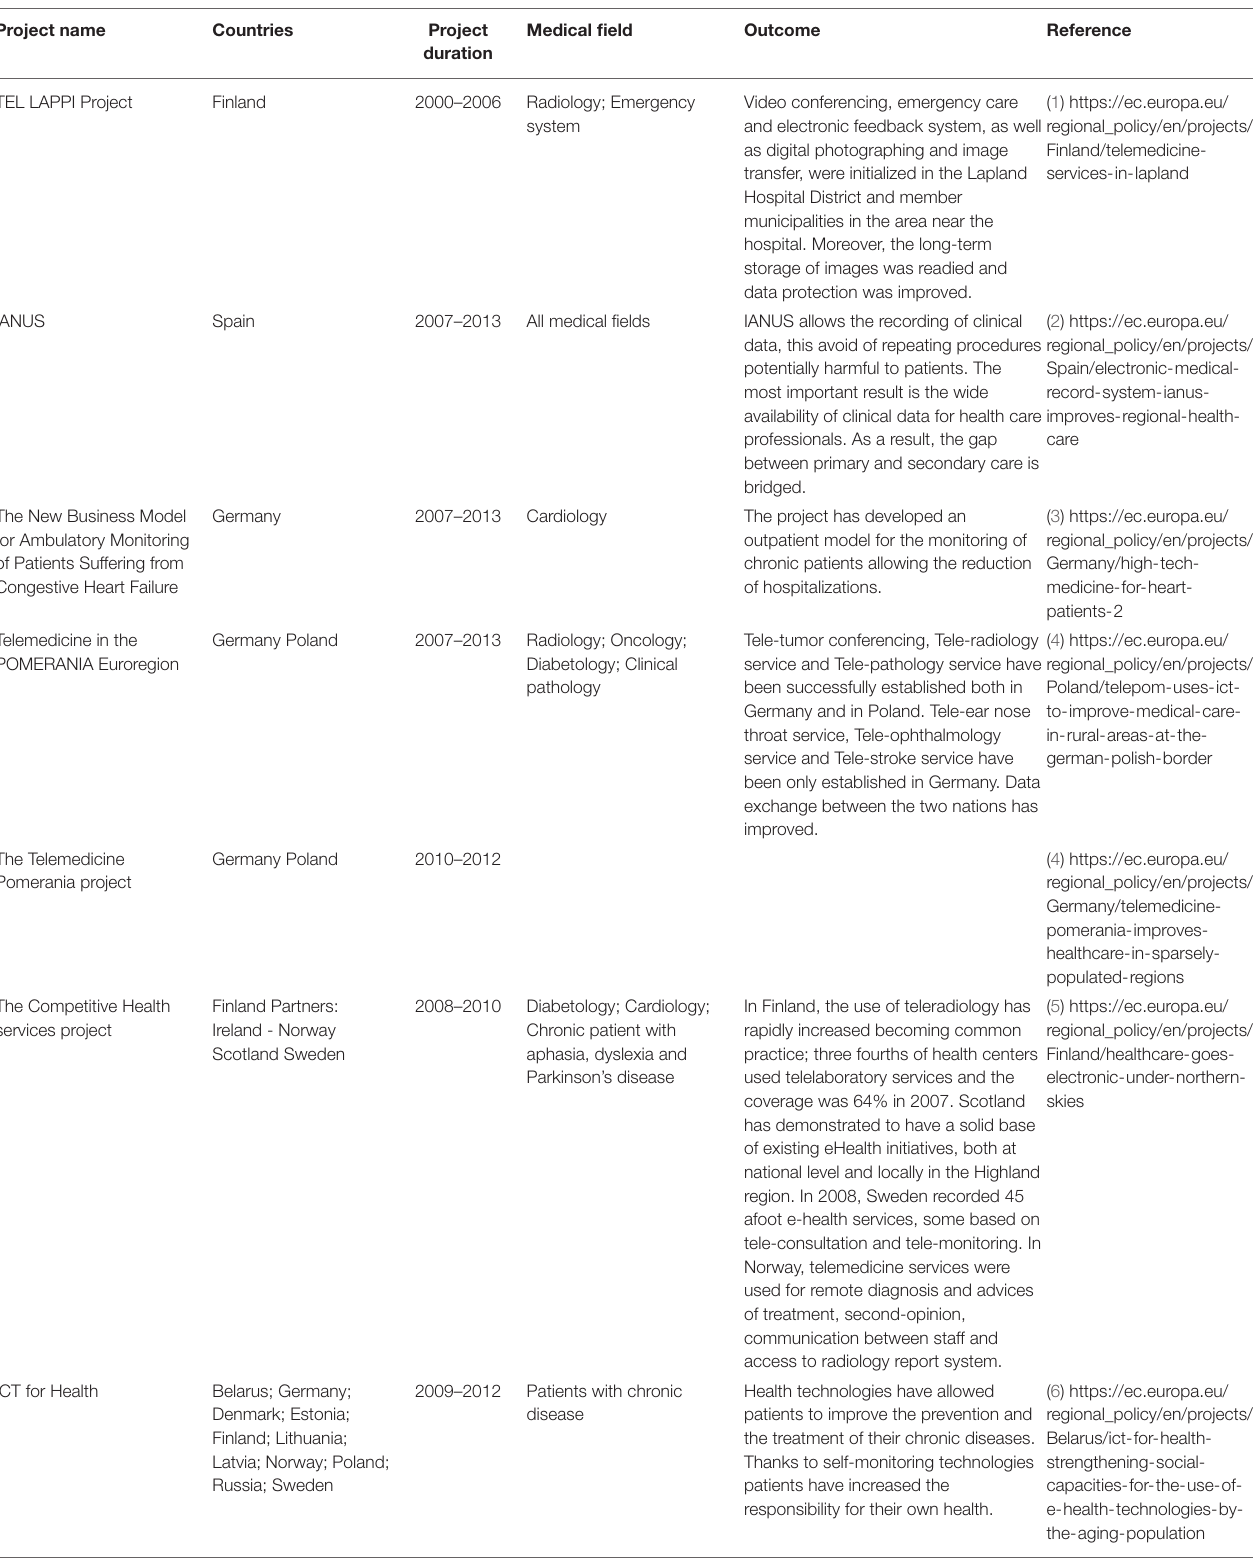
TABLE 1 | Projects